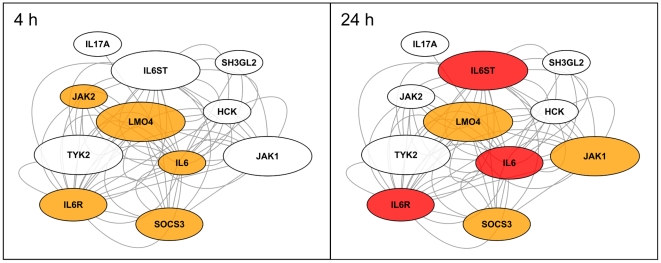
Transcriptional changes observed for genes encoding IL6-interacting proteins in PC-3 cells after PpIX-mediated PDT.The changes of gene expression 4 h and 24 h after PDT measured by oligonucleotide microarray analyses are depicted as fold change (fluorescence of irradiated/non-irradiated sample). The magnitude of fold change is indicated by different colors (<1.2-fold, white; ≥1.2-fold, <2-fold, orange; ≥2-fold, red). The strongest upregulation of expression was observed for the IL6 gene (12.3-fold) which could part of an autostimulatory loop with the also upregulated IL6 receptor subunits (IL6R and IL6ST). The size of the ovals indicates the absolute expression level after PDT (<100 FU, small symbol; ≥100, <1000, medium symbol; ≥1000, large symbol). The lines between the ovals symbolize various types of interaction between the proteins or genes.